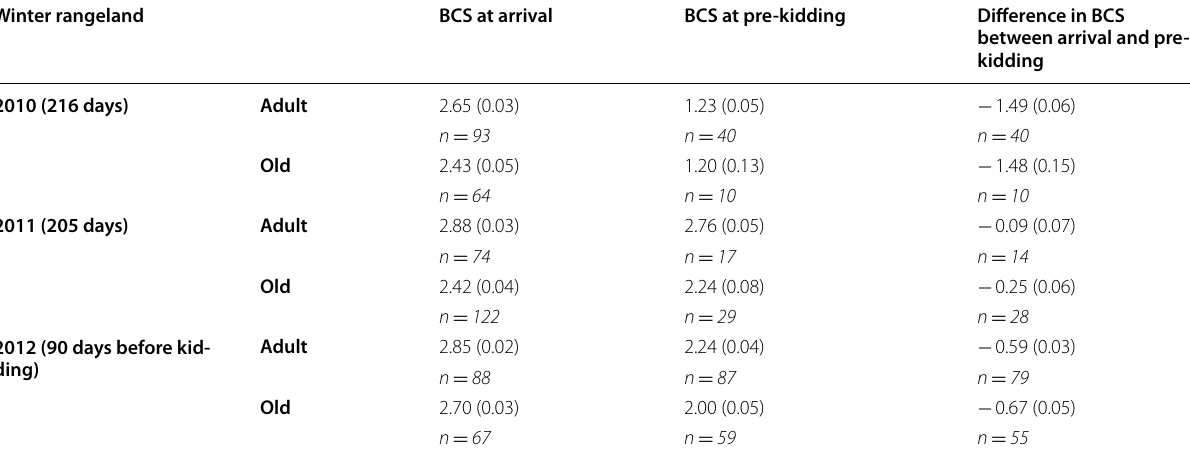
The number of goats evaluated is in italics. The standard error of the mean is between the